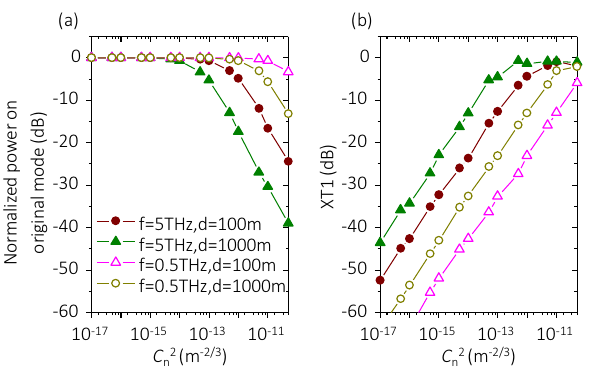
10 -17 10 -15 10 -13 10 -11 2 Figure 8. Effects of varying C n on system performance. 100-m links with ( a ) 2 1 × 10 –13 m −2/3 , and ( c ) C n = 1 × 10 –11 m −2/3 . Other parameters are set as w 0 = 1 m, f = 5 THz, and OAM + 4 is transmitted. Legends and scales in y -axis in ( a – c ) are the same. XT